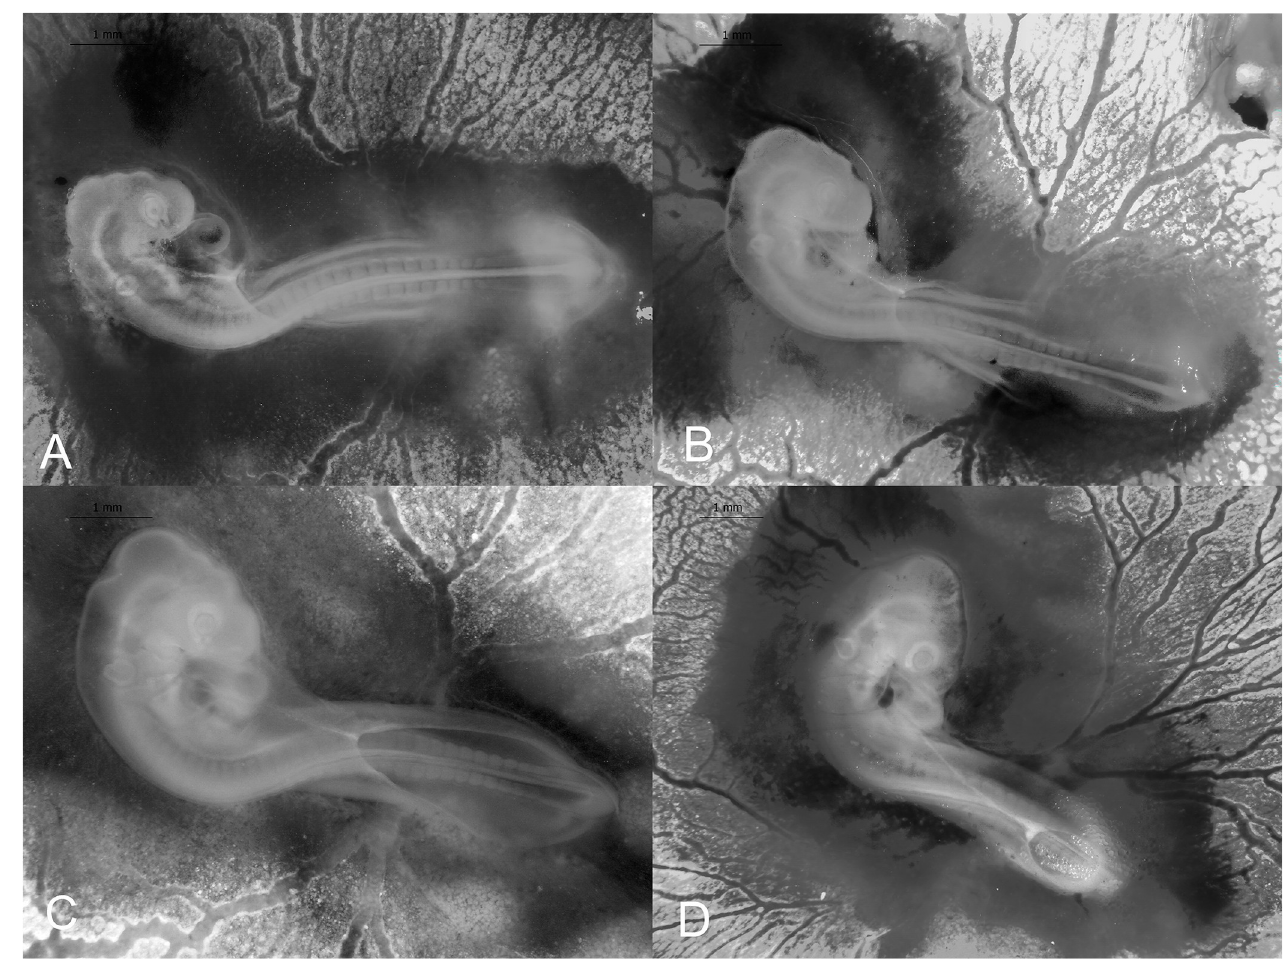
Fig 5. Stages 15–18 (66–84 h) of the California valley quail’s embryological stages of development. (A) Stage 15, 24 somite pairs present. Optic cup and double contour has formed. (B) Stage 16, 26–28 somite pairs present. (C) Stage 17, nasal pits are visible and amnion extends toward trunk. (D) Stage 18, first appearance of wing-bud. Amnion enclosed except for small oval on the trunk.